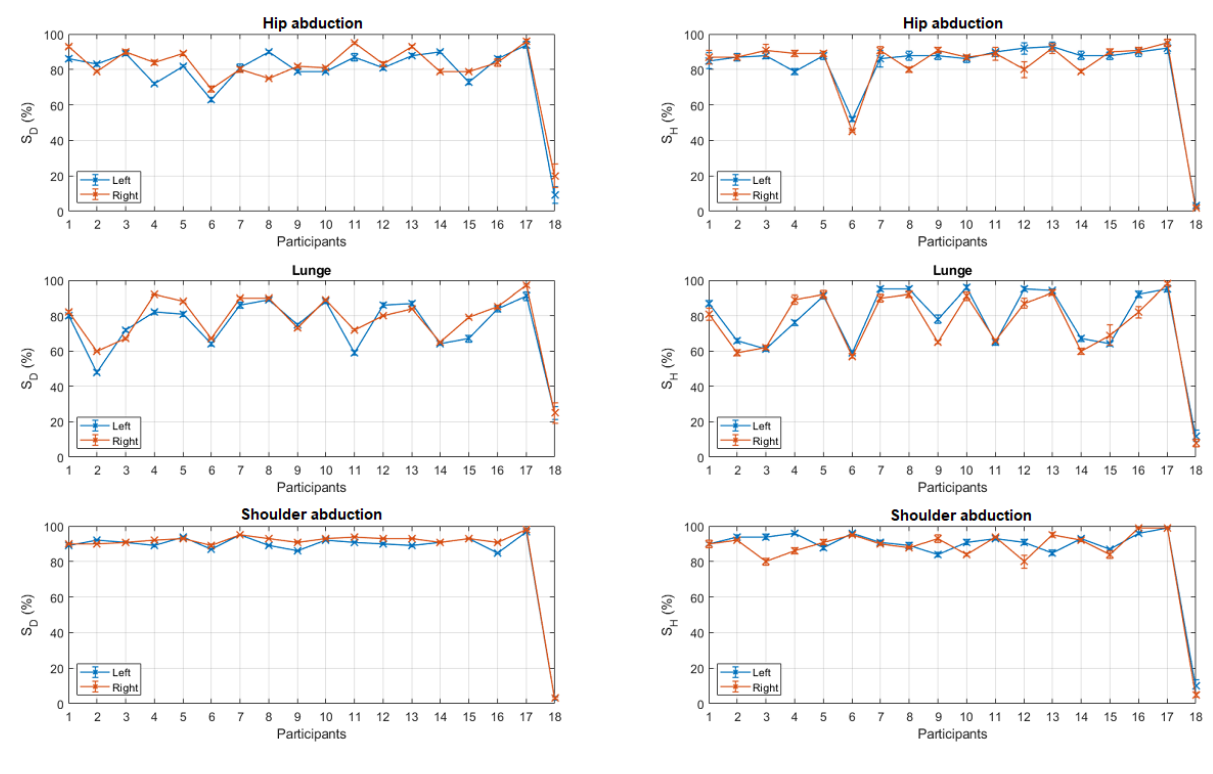
Figure 12. Comparison between left and right scores. Error bars indicate standard error.